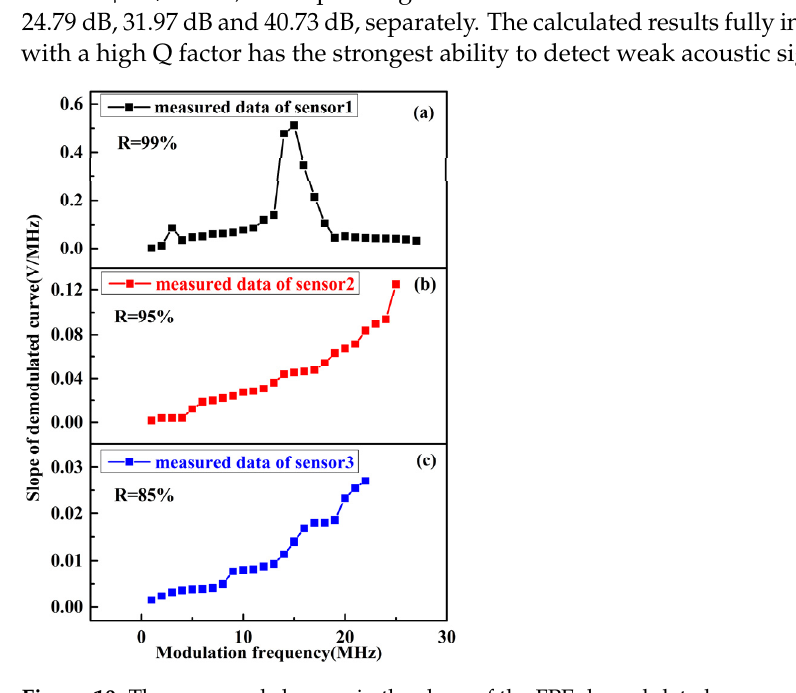
Figure 10. The measured changes in the slope of the FPE demodulated curve with different Q factors under different modulation frequencies: ( a ) R is 99%; ( b ) R is 95%; ( c ) R is 85%.